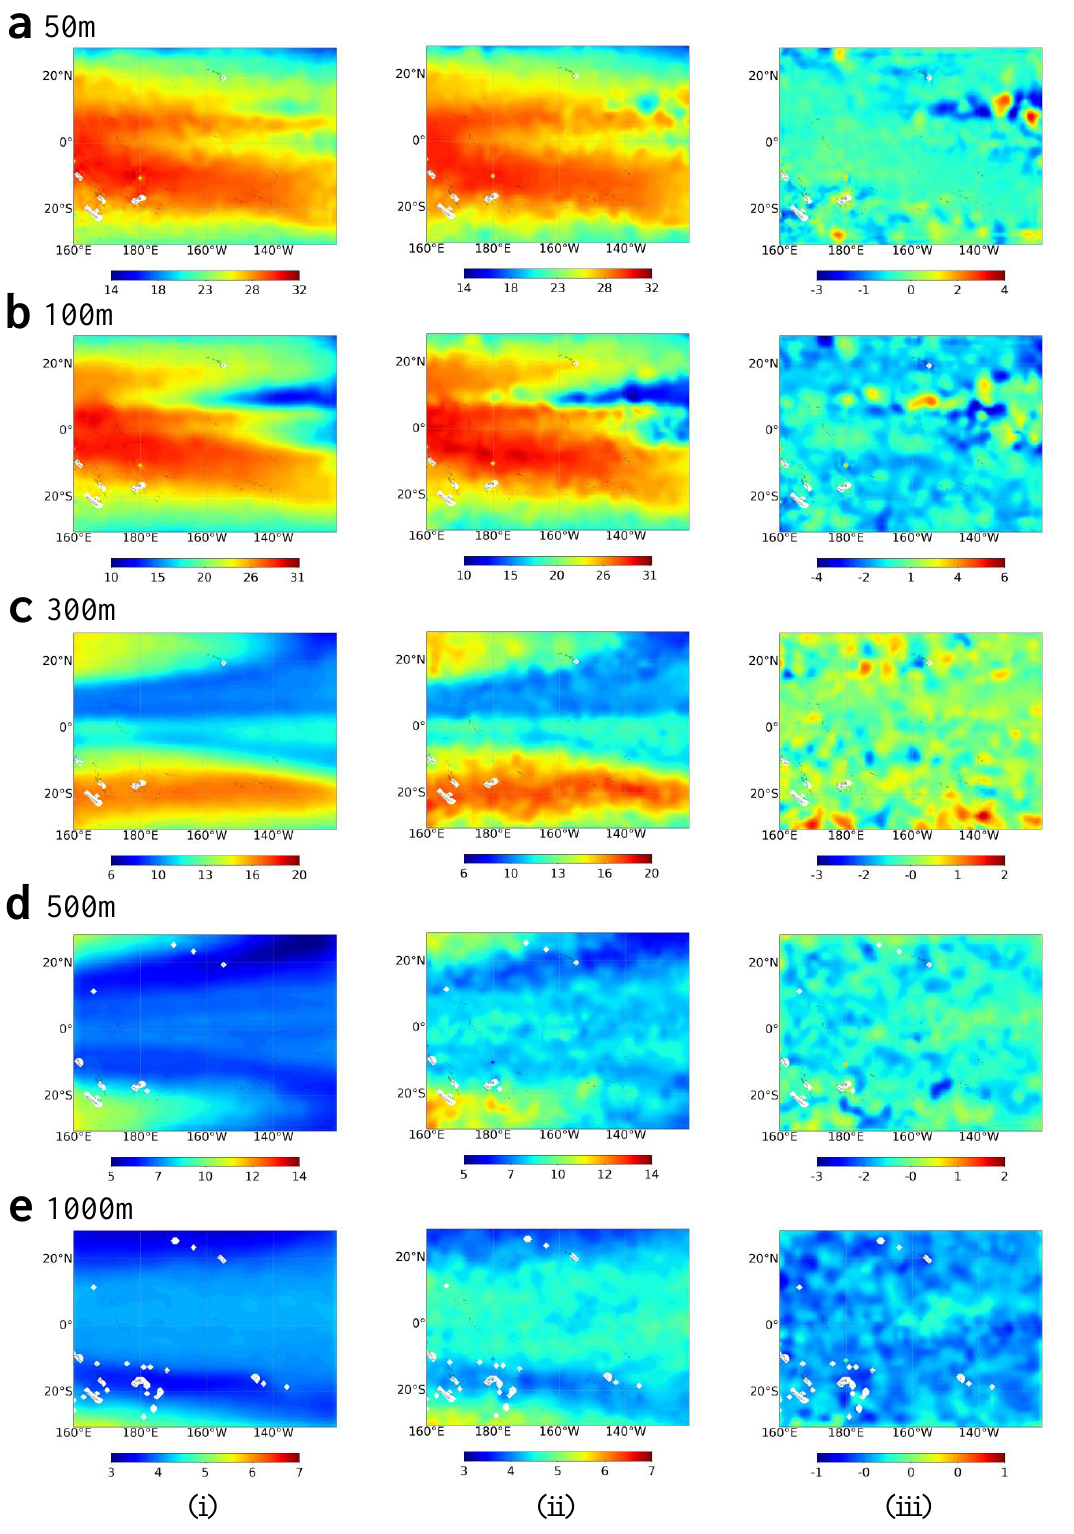
Figure 4. Spatial distribution of ConvLSTM-reconstructed ST in (i) Case 4A and (ii) Argo ST, and (iii) the absolute error of ConvLSTM-predicted ST at depth levels of ( a ) 50 m, ( b ) 100 m, ( c ) 300 m, ( d ) 500 m, and ( e ) 1000 m in March